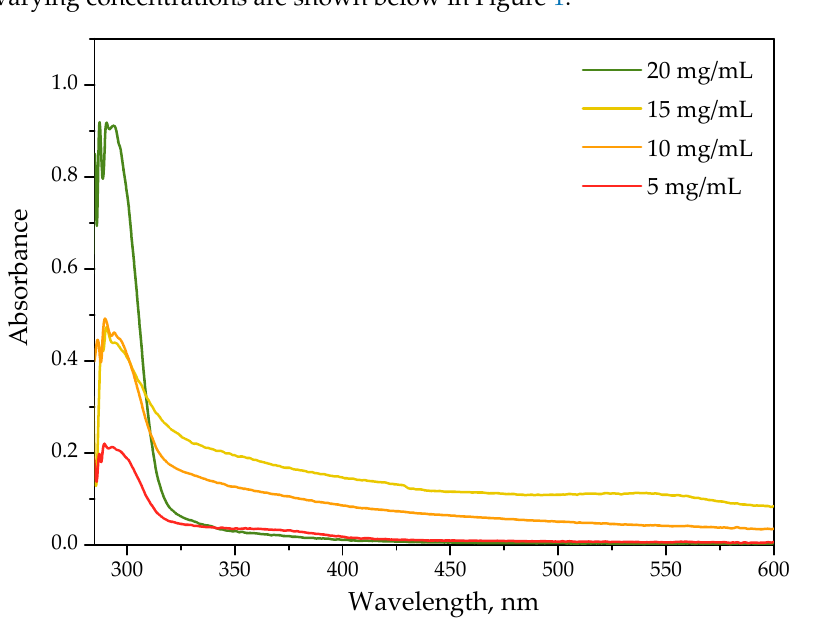
Figure 1. UV-Vis spectra of protein particles suspensions obtained using various concentration of albumin solution.